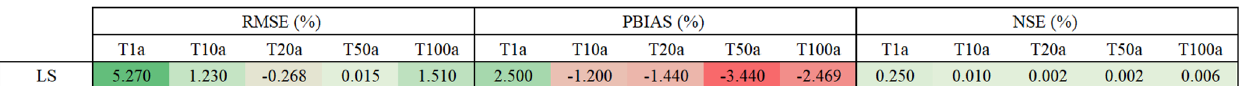
Table 8. Median performance improvement/deterioration (%) of ordinary kriging (OK) versus index-based (INDEX) regionalisation calcu- lated for different data as per Eq. (15) (where new is OK and ref in INDEX), when only long series (LS) are used as input. The performance is obtained by cross-validation over 133 LS stations. The colour green ( + ) indicates better performance by OK, and red (–) indicates better performance by INDEX.